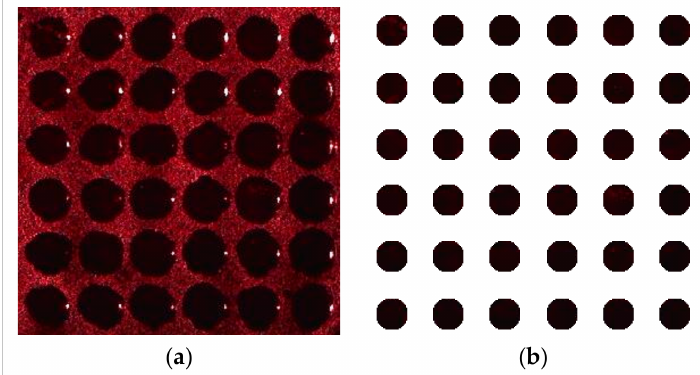
Figure 17. ( a ) Actual PSi microarray image obtained with digital imaging equipment; ( b ) measured PSi microarray image after pretreatment, correction, and segmentation.